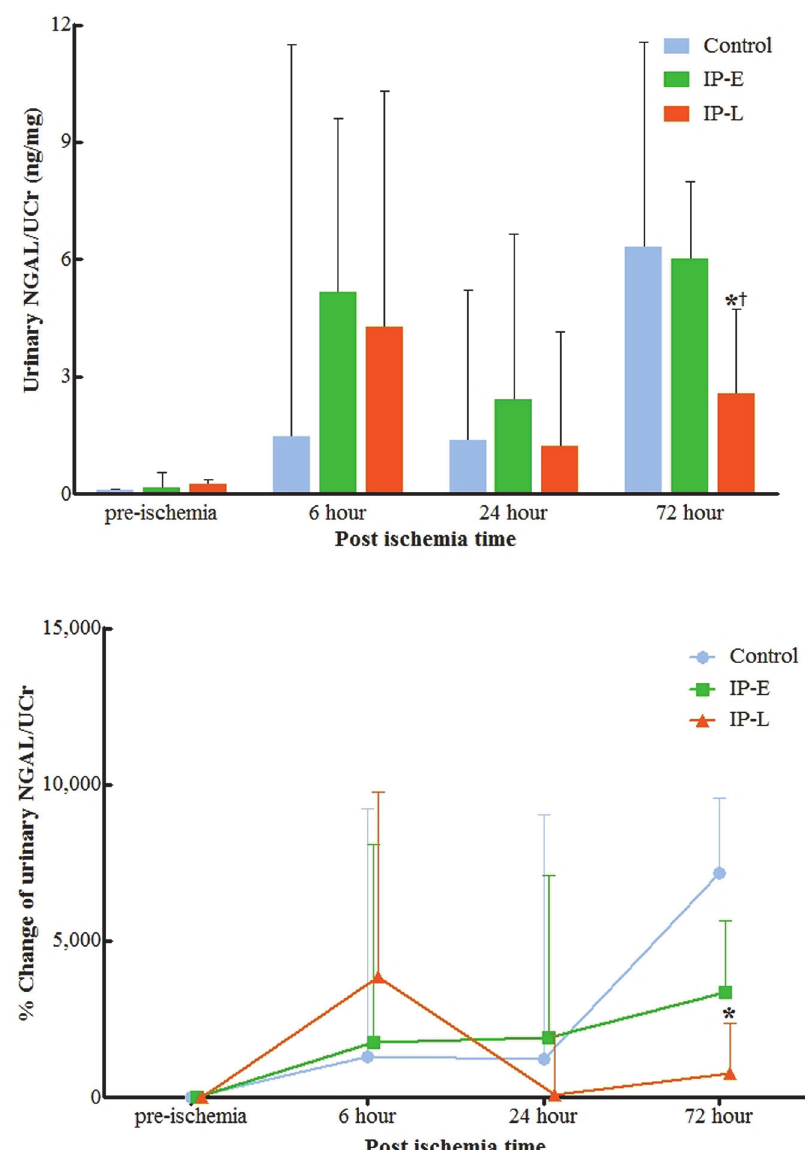
control and IP-E groups (p = 0.076 and 0.047, respectively). NGAL, neutrophil gelatinase-associated lipocalin; Ucr, urine creatinine; IP-E, remote ischemic preconditioning with early window; IP-L, remote ischemic preconditioning with late window. * p < 0.05 vs. Control, † p < 0.05 vs.